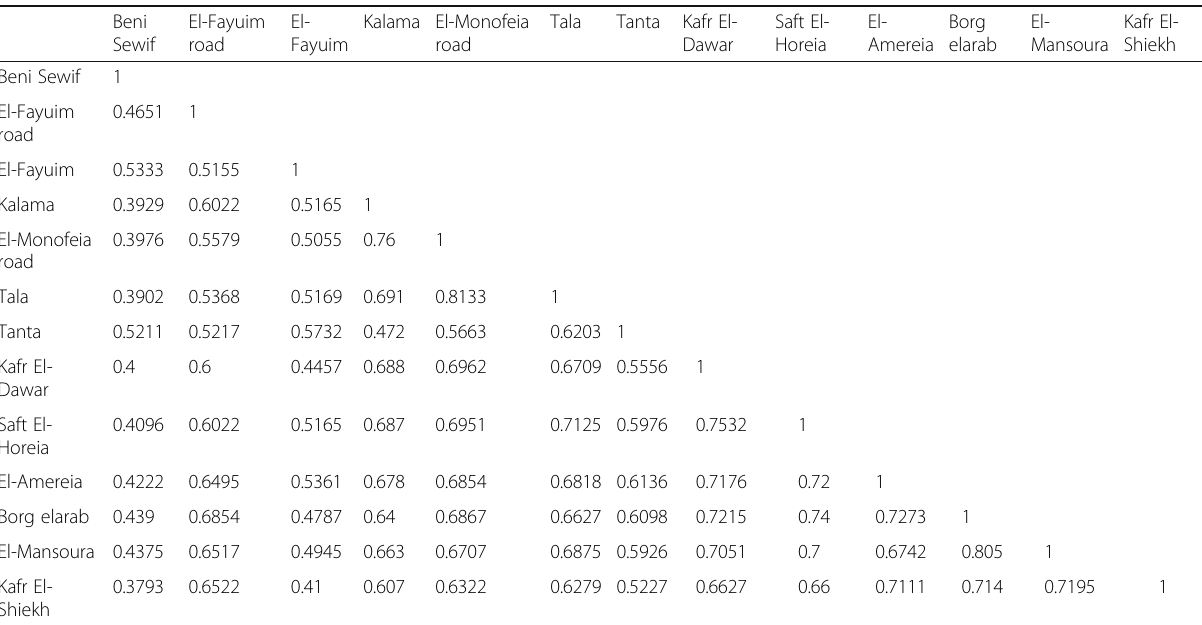
Table 7 Euclidean distance based on biochemical and molecular markers showing the variability among the studied samples of Silybum marianum Beni